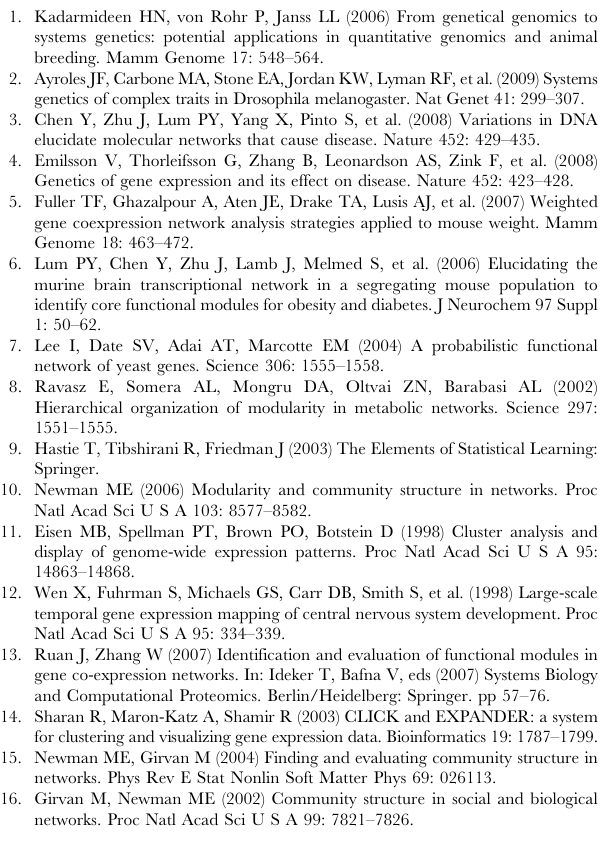
Figure S1 Comparison of monotone transformations. The absolute correlation coefficient r j j is compared to its value after transformation by each of two nonlinear monotone functions. On the left is the Gaussian function used by MMC which transforms r j j into e r j j { 1 ð Þ = s 2 . On the right is the power function r j j s . Note that the x -axis of the power function is coarser than that of the Gaussian function by a factor of